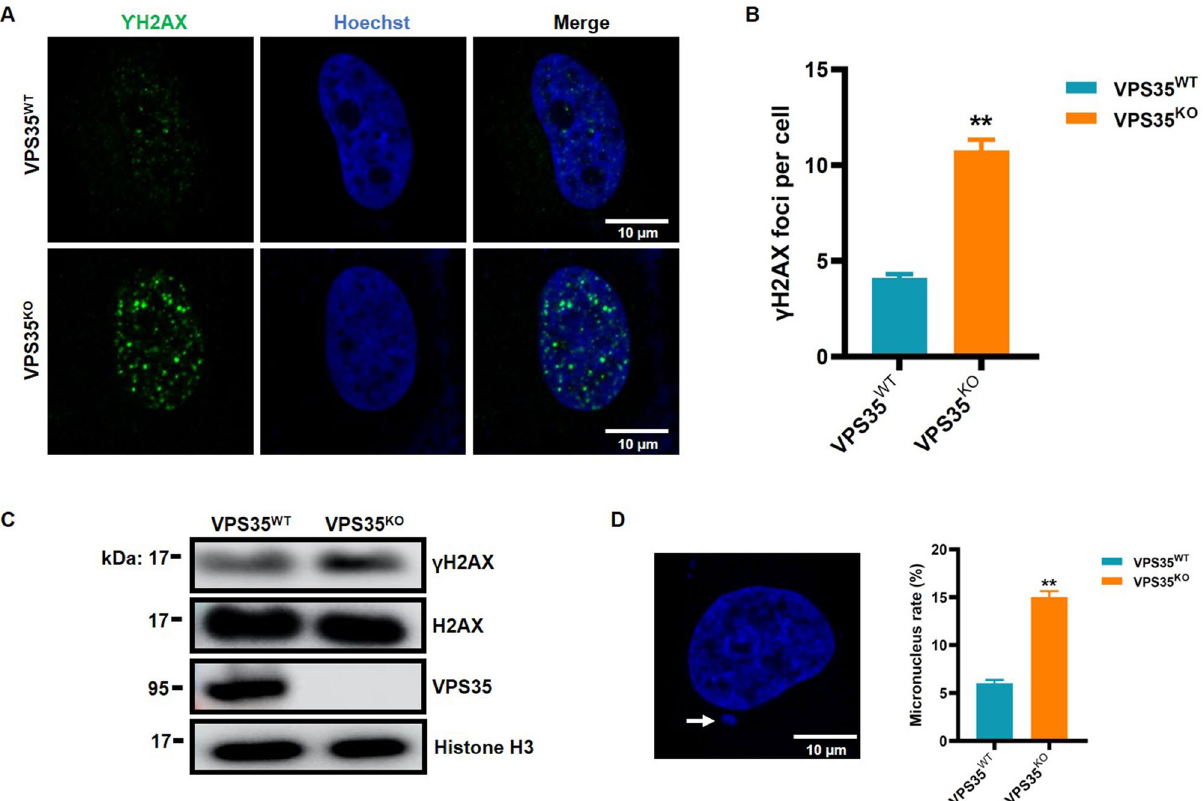
Figure 7. VPS35 contributes to the maintenance of genome stability. ( A ) Representative confocal images of HeLa cells labeled with anti-γH2AX antibody. ( B ) Numbers of γH2AX foci per cell were calculated for at least 200 cells of each group and presented as the mean ± S.D. **, p < 0.01 vs. VPS35 WT . ( C ) The nuclear protein extracts were isolated, and the level of γH2AX was examined by western blotting. ( D ) A micronucleus assay was performed to assess genomic instability. At least 500 cells were examined, and the frequency of cells with micronuclei was calculated. **, p < 0.01 vs. VPS35 WT